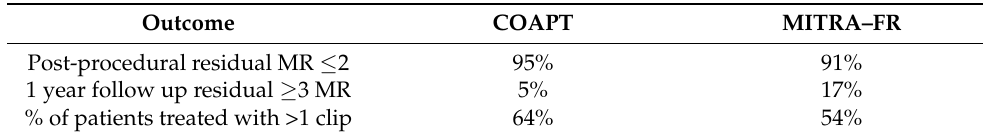
Table 6. Main procedural